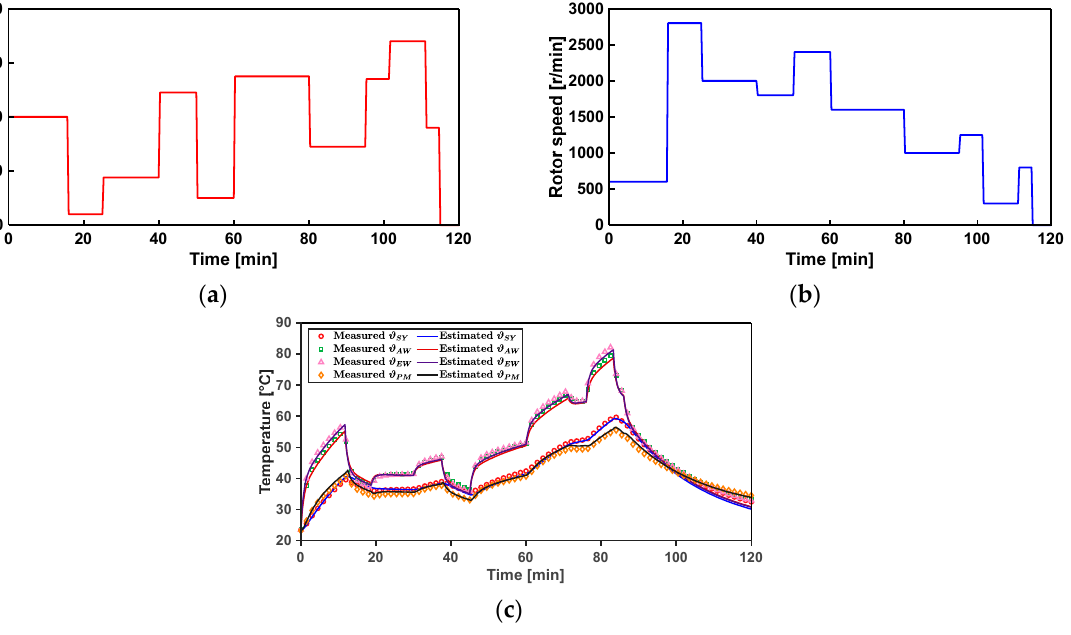
Figure 41. Experimental validation of well-trained grey-box thermal model under two-hour varying load conditions [84]. ( a ) Load condition. ( b ) Rotor speed. ( c ) Temperature profiles.